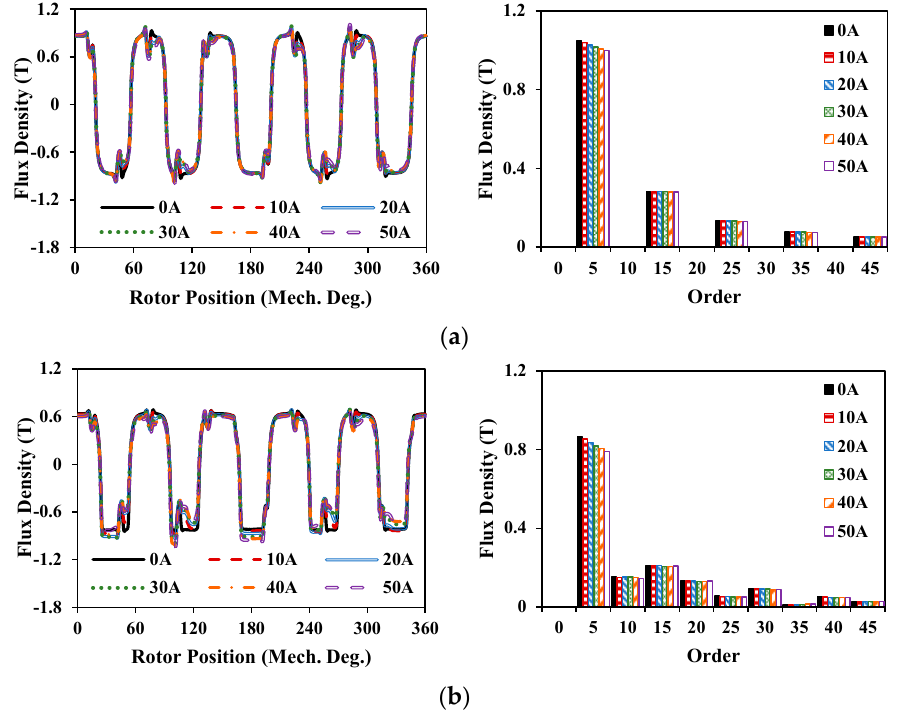
Figure 5. Air-gap flux densities and spectra for 12s8p machines. ( a ) 12s10p-SPM. ( b ) 12s10p-CCPPM.